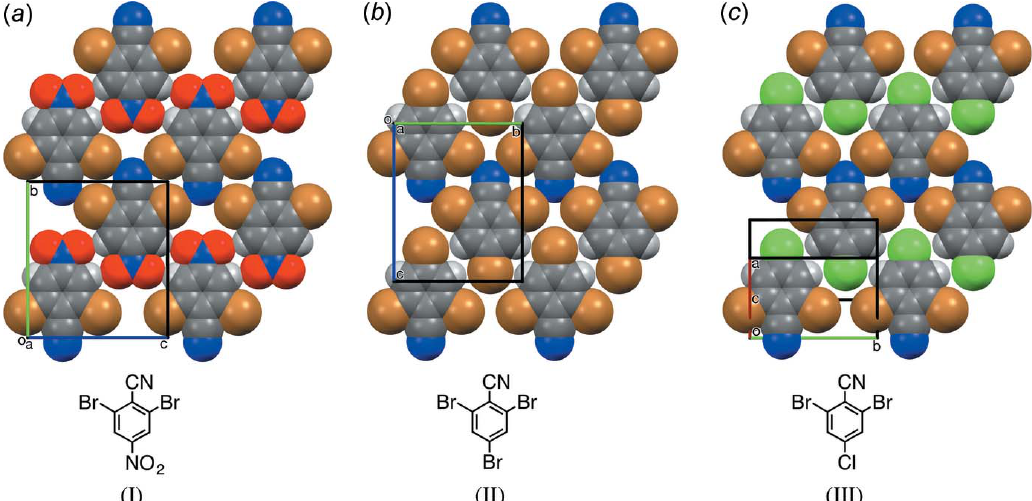
Figure 2 Space-filling drawings of the sheet structures in ( a ) 4-nitro nitrile (I), viewed along [100]; ( b ) the Z = 8 polytype of 4-bromo nitrile (II), viewed along [100]; ( c ) 4-chloro nitrile (III), viewed along [102].